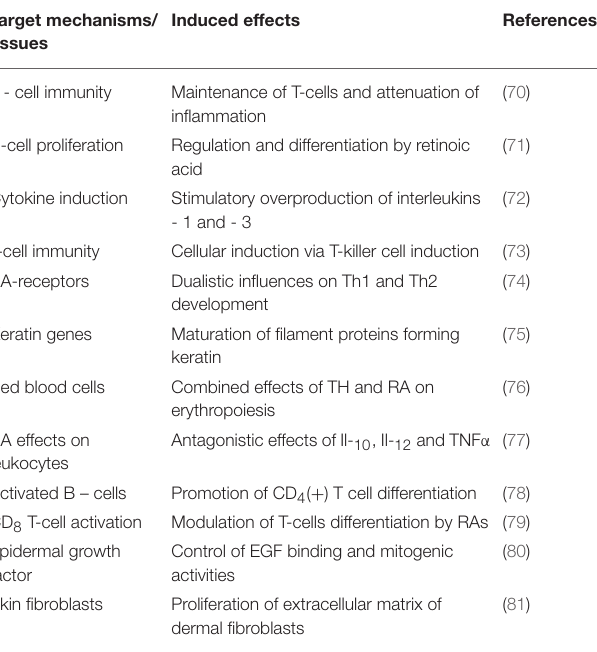
TABLE 3 | Stimulatory effects of retinoid compounds in inflammatory